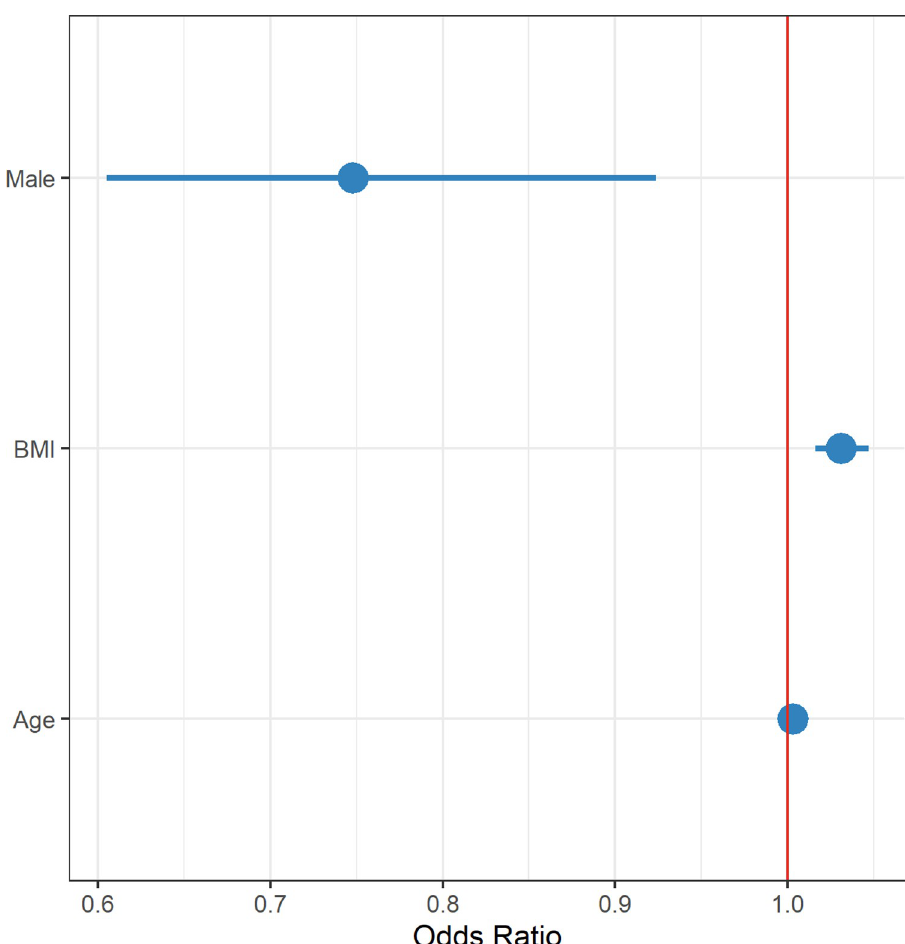
Fig 2. Regression model for covariates with p < 0.1. Sex and BMI were statistically significant whilst age showed a trend towards significance.